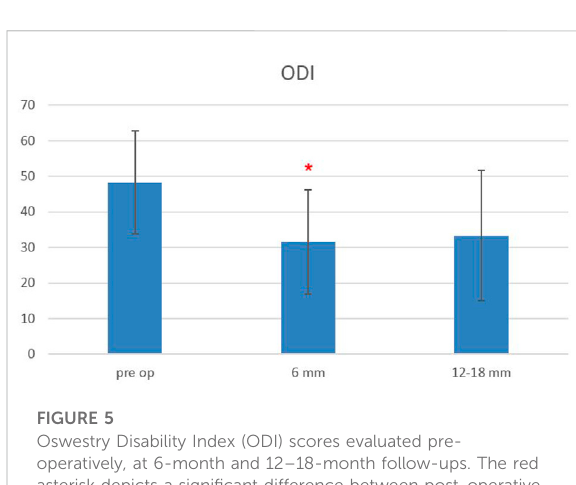
FIGURE 5 Oswestry Disability Index (ODI) scores evaluated pre- operatively, at 6-month and 12 – 18-month follow-ups. The red asterisk depicts a signi fi cant difference between post-operative and pre-operative values.